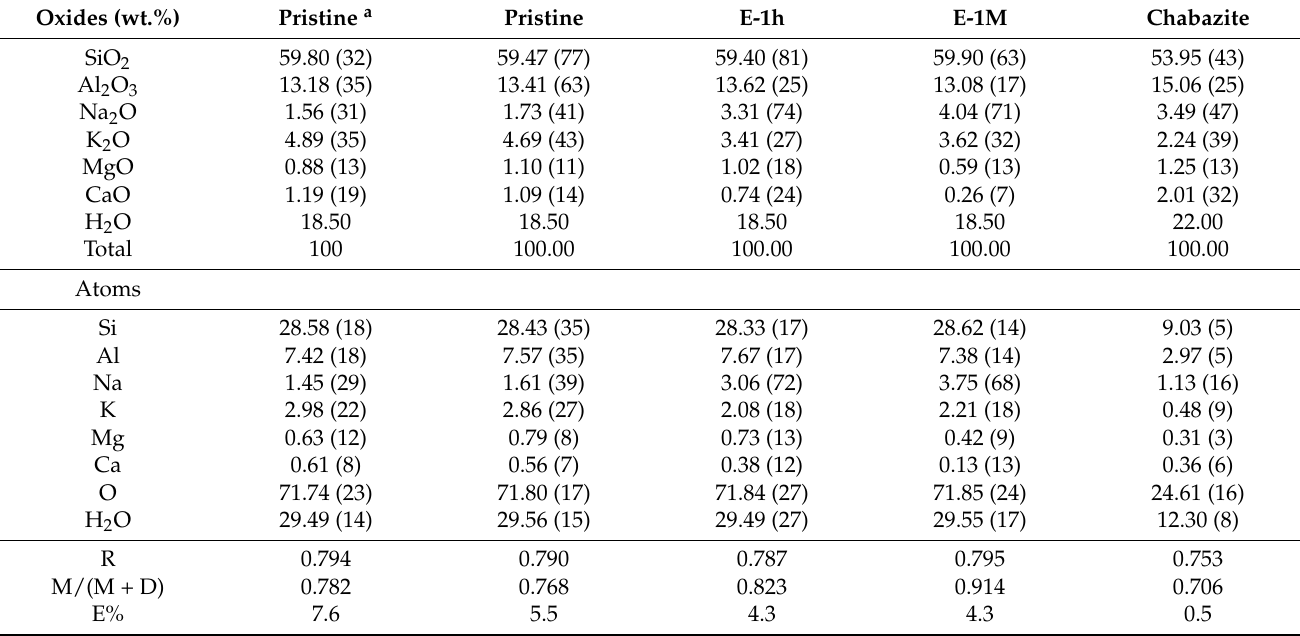
Table 3. Chemical analyses, by SEM-EDX, of both pristine and incubated erionite fibres for one hour (E-1H) and one month (E-1M) in the mimicked Gamble’s solution. In addition, data of pristine chabazite are reported. Chemical formulae were not calculated in the case of analyses characterized by E% exceeding 10%. Standard deviations are reported in parenthesis. Oxides (wt.%) Pristine a Pristine E-1h